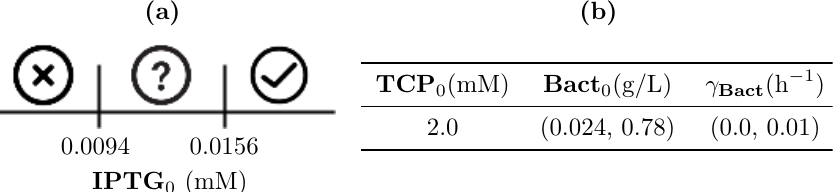
Figure 14. Diagram for satisfiability of Property 6 reflecting IPTG 0 . ( a ) A simple diagram presenting the qualitative results of robustness monitoring for Property 6. It shows the influence of IPTG 0 on the satisfiability of the particular property. The two thresholds divide the area of influence into three sections. The left one which robustly violates the property, the right one—satisfying the property (robustly)—and the middle one where the result is not robust. This result holds for all combinations of the parameters (and variables) in the table ( b